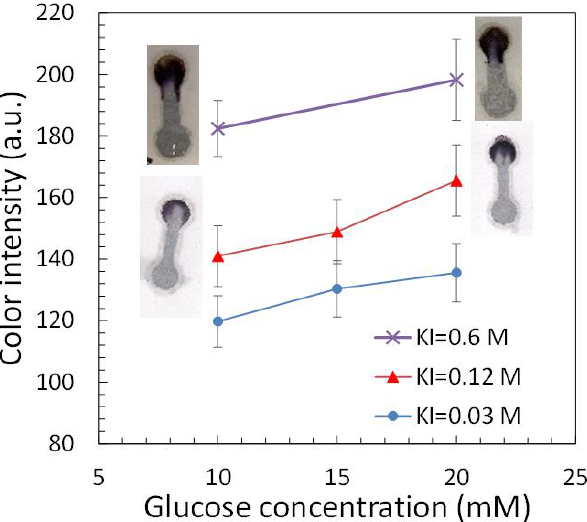
Figure 9. The color intensity for glucose detection at different KI concentrations. For microfluidics made of printing paper for diabetes monitoring, the KI concentration could be adjusted to 0.12 M such that the difference in glucose concentration in the blood samples from healthy people ( ≤ 10 mM) and diabetic patients ( ≥ 20 mM) can be